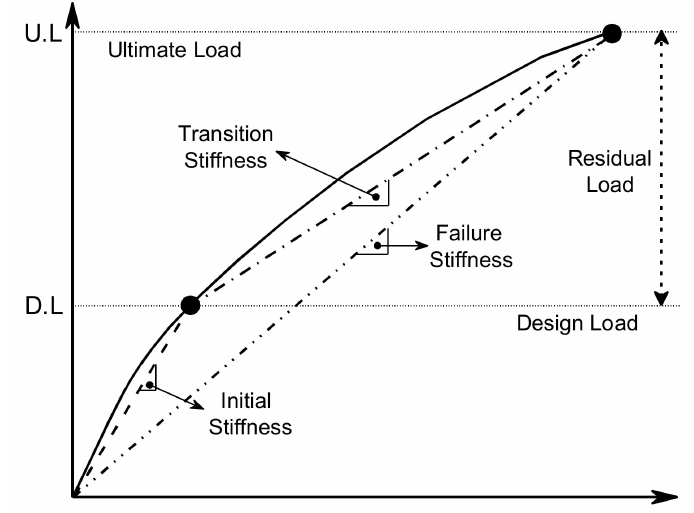
Figure 4. Definitions of Load and